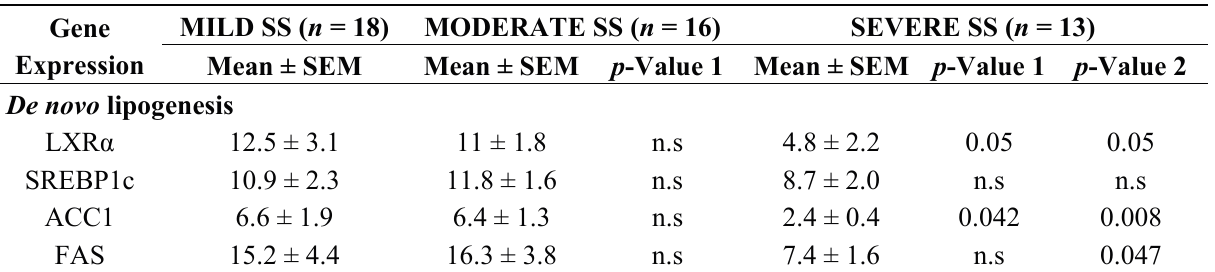
Table 3. Hepatic expression of genes related to de novo fatty acid synthesis, fatty acid uptake and transport, fatty acid oxidation, and inflammation in morbidly obese women diagnosed with different degrees of simple steatosis